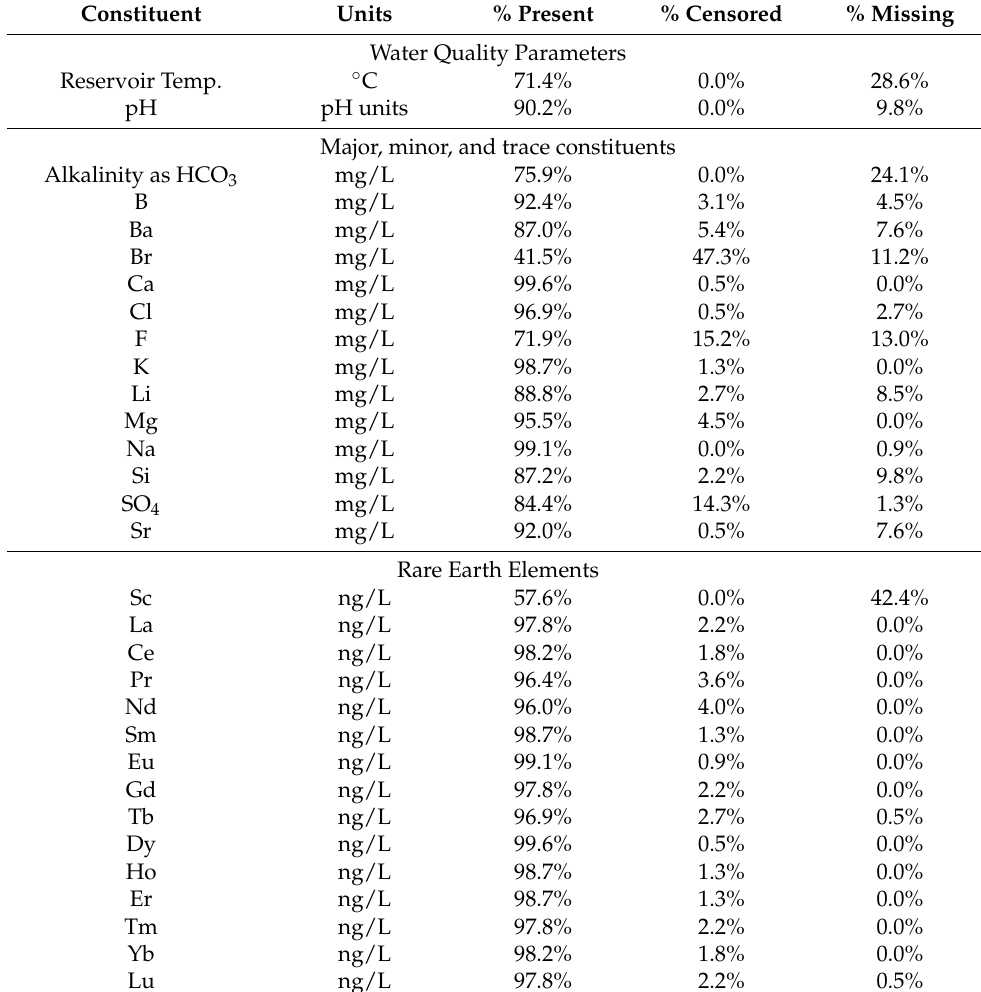
Table 2. List of parameters used in the input dataset indicating units, and relative proportion of present, censored, and missing data. Constituent Units % Present % Censored % Missing Water Quality Parameters Reservoir Temp.